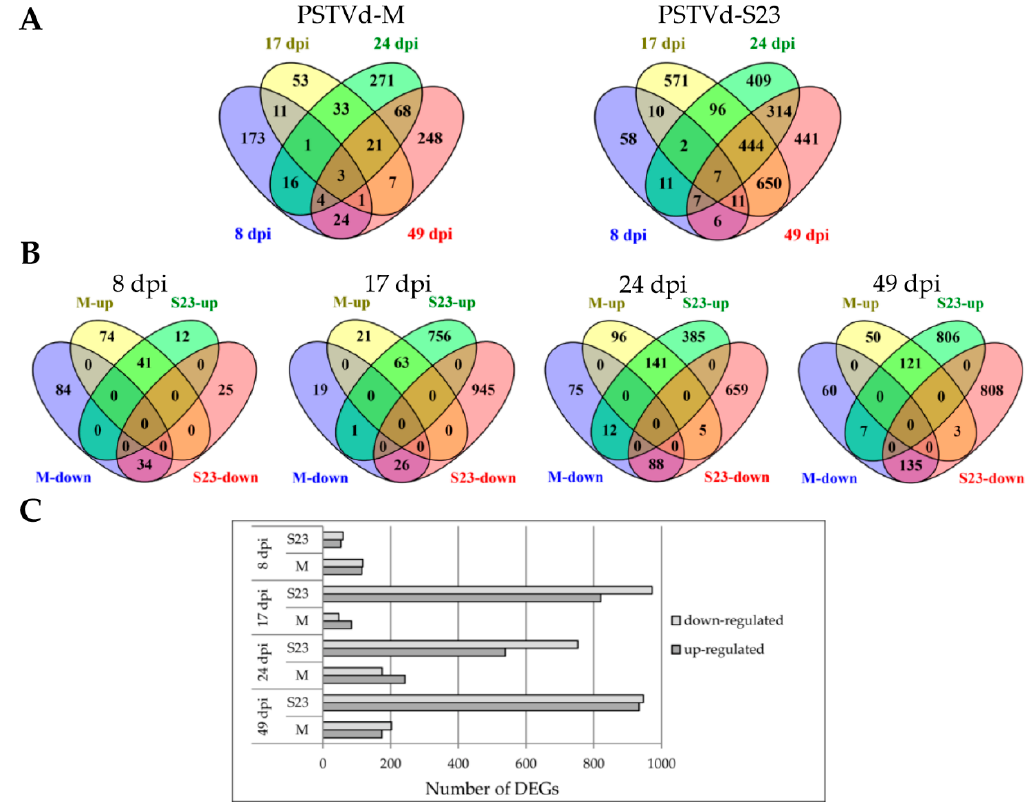
Figure 2. Relationship of DEGs at different time points. ( A ) Venn diagrams display the distribution of DEGs at each time point during mild or severe infection. ( B ) Venn diagrams display the distribution of up- and down-regulated genes in both infections at each time point. ( C ) Comparison of the number of up- and down-regulated genes at each time point.